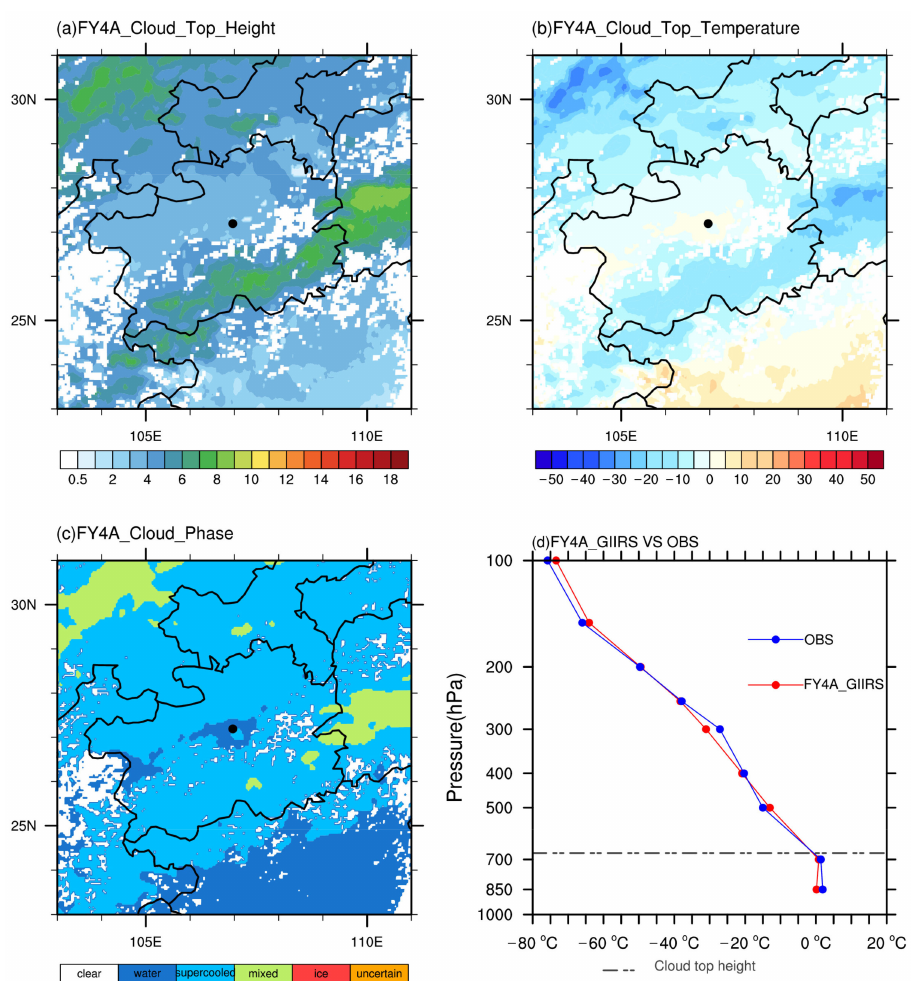
Figure 10. FY-4A AGRI cloud top information ( a ) cloud top height (km), ( b ) cloud top temperature ( ◦ C), ( c ) cloud phase, ( d ) GIIRS temperature profile vs. radiosonde observation at 08:00 on 28 January 2022 (black dot: the location of Guiyang). The quality flags of GIIRS profile in Figure 10d are 0 (100 hPa), 0 (150 hPa), 0 (200 hPa), 0 (250 hPa), 0 (300 hPa), 0 (400 hPa), 0 (500 hPa), 0 (700 hPa), 0 (850 hPa). The quality flags are 0, 1, 2 and 3, which represent perfect data, good data, bad data and very bad